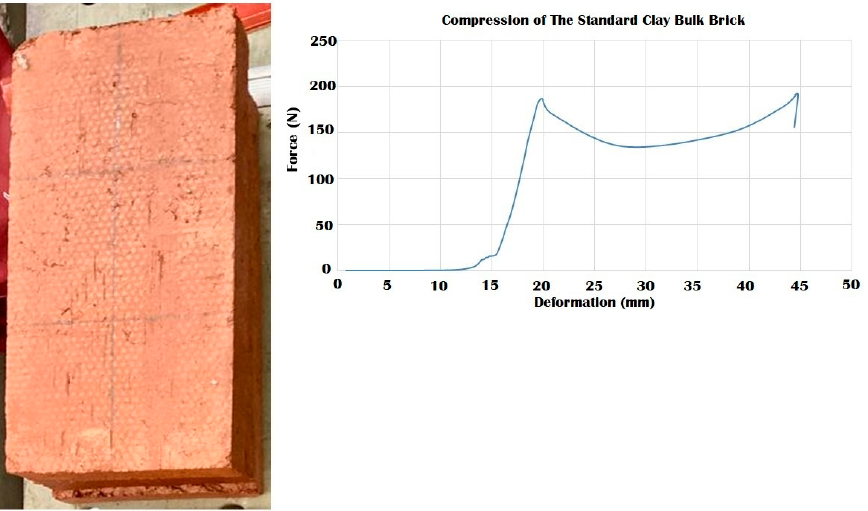
Figure 17. Exhibits the results of the compression test for the standard industrial clay brick. The results show that the maximum compressive force endured by the brick was 190 N which led the brick to its first cracking point at 20 mm deformation. While the brick maintained resistance from 20 to 44.5 mm deformation under forces ranging from 140–200 N with a strain value of 0.99, where it finally collapsed at ⁓ 200 N, which is less than the compressive strength achieved by the V1 linear and bulk brick model of the 3DPBDCB that endured until 240 N before a partial collapse in the case of its linear model and without collapsing in its bulk model.